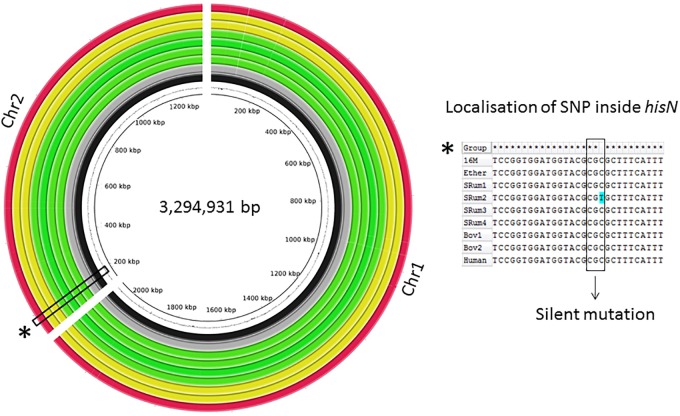
Circular alignment representation of investigated Brucella melitensis bv3 genomes. Genomes of seven clonal B. melitensis bv3 isolates were de novo assembled. BRIG alignment of investigated genomes and Ether against 16M are shown. Rings from inside to outside: GC-% of 16M, 16M (black), Ether (gray), B. melitensis bv3 isolated from small ruminants (n = 4) (green), from bovine (n = 2) (yellow) and from human (n = 1) (red). Alignment of the hisN region flanking the unique SNP between seven isolates generated with ClustalW.